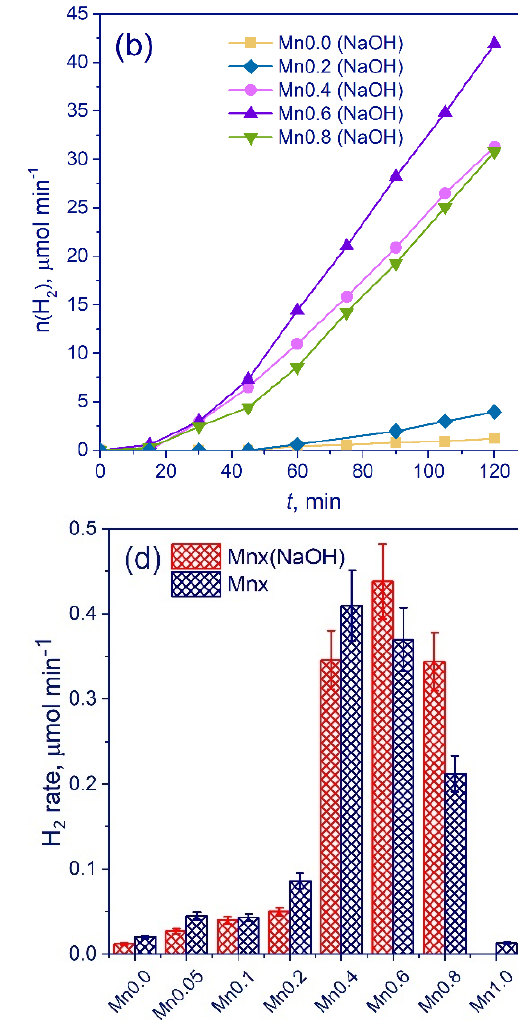
Figure 6. Time plots of hydrogen evolution for series Mnx ( a ) and Mnx(NaOH) ( b ); emission spectrum of 450-LED used as a light source ( c ) and dependence of the rate of photocatalytic hydrogen evolution on the manganese content for the series Mnx (x = 0–1.0) and Mnx(NaOH) (x = 0–1.0) ( d ). Conditions: C 0 (Na 2 S/Na 2 SO 3 ) = 0.1 M, C cat = 0.50 g L − 1 , λ = 450 nm.